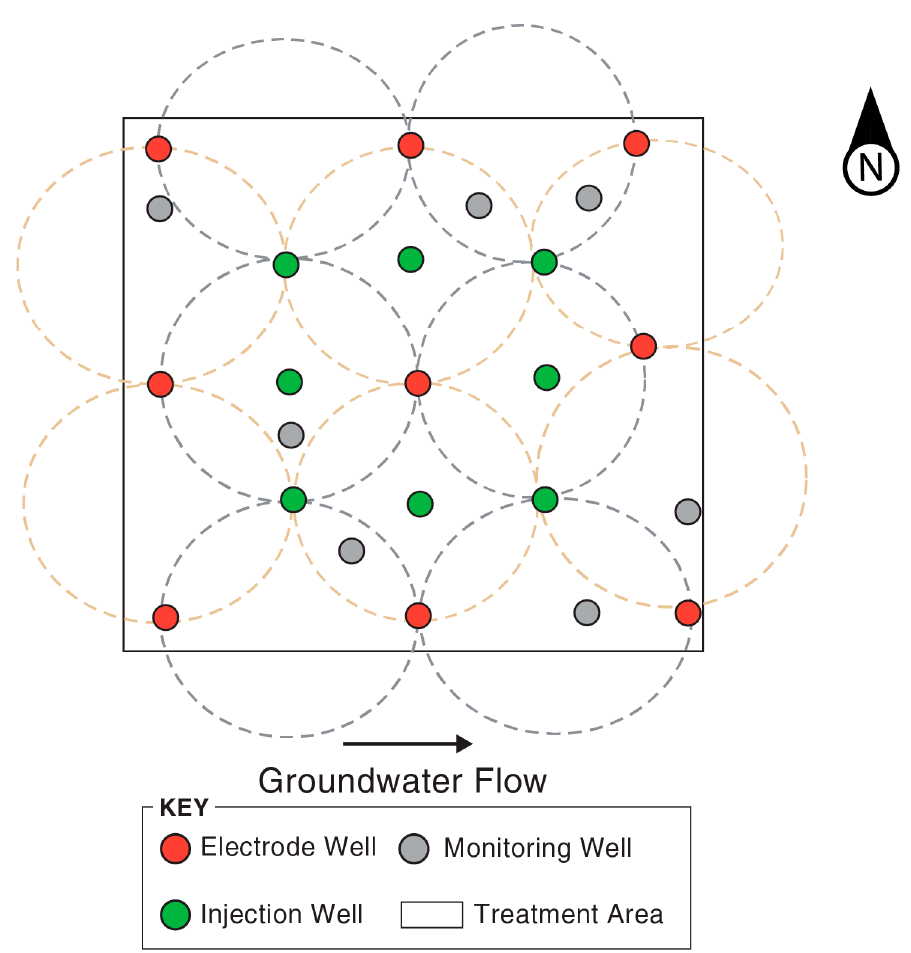
Figure 4. Well layout in the 12 m by 12 m EK treatment area with electrodes (red circles), amendment injection well (green circles), and monitoring wells (gray circles). The electric fields during Stages 1 and 2 are conceptually represented by the blue dashed lines and orange dashed lines, respectively. Adapted from Cox et al. [64].